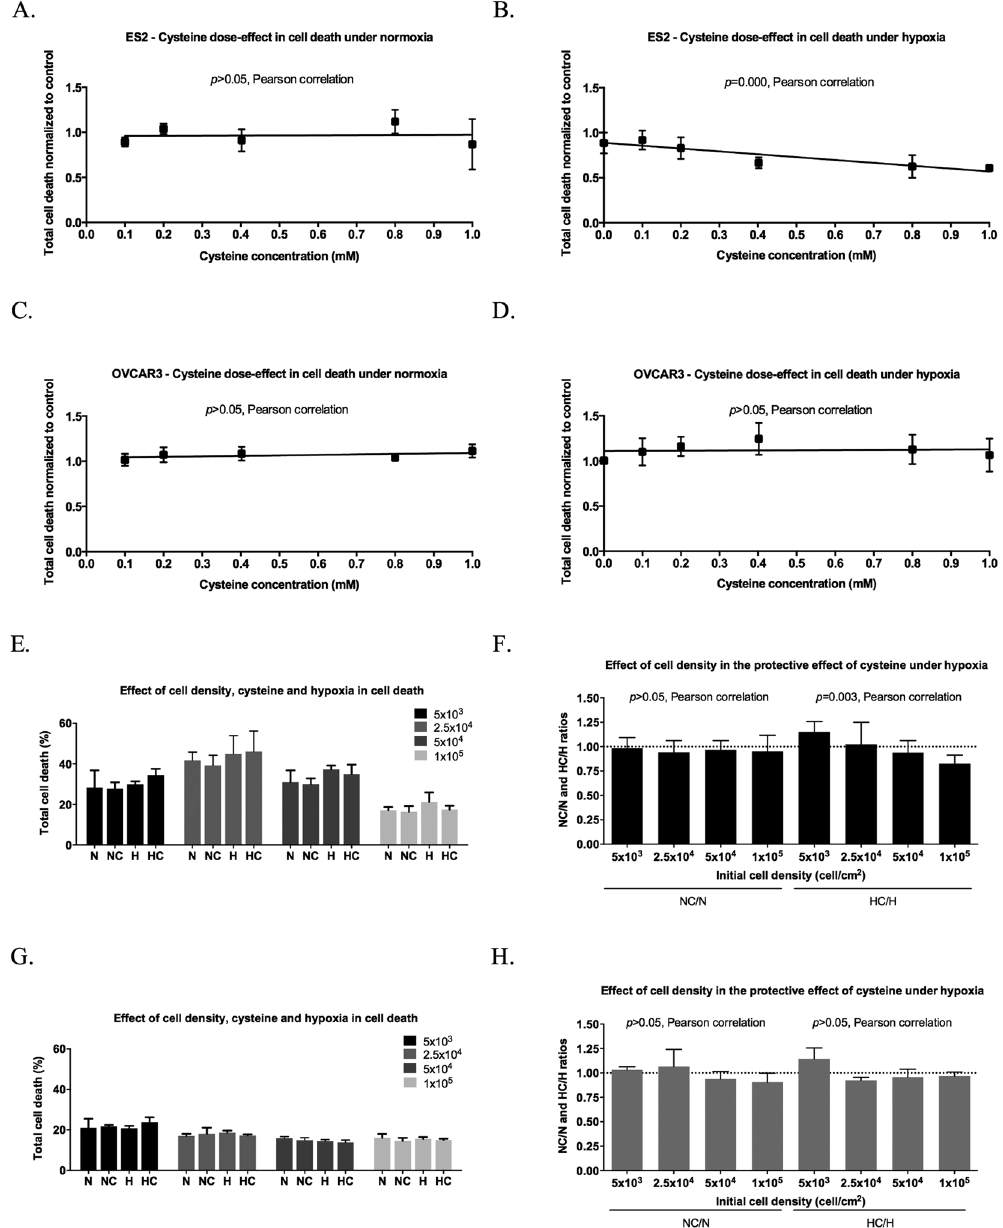
Figure 2. The dose dependent and cell density dependent effects of cysteine in hypoxia adaptation in ES2 (OCCC) and OVCAR3 (OSC) cells. ( A ) Pearson correlation under normoxia for ES2 cell line. ( B ) Pearson correlation under hypoxia for ES2 cell line. ( C ) Pearson correlation under normoxia for OVCAR3 cell line and ( D ) Pearson correlation under hypoxia for OVCAR3 cell line for 16 h of assay. Treatments were normalized by the control values (normoxia without cysteine supplementation). ( E ) Percentage of total cell death for ES2 cells for 16 h of assay for different initial cell densities. ( F ) Pearson correlation for NC/N and HC/H ratios for ES2 cells. ( G ) Percentage of total cell death for OVCAR3 cells for 16 h of assay for different initial cell densities and ( H ) Pearson correlation for NC/N and HC/H ratios for OVCAR3 cells. N – Normoxia; NC – Normoxia supplemented with cysteine; H – Hypoxia; HC – Hypoxia supplemented with cysteine. 5 × 10 3 , 2.5 × 10 4 , 5 × 10 4 and 1 × 10 5 refers to initial cell densities expressed as cells/cm 2 . Results are shown as mean ±